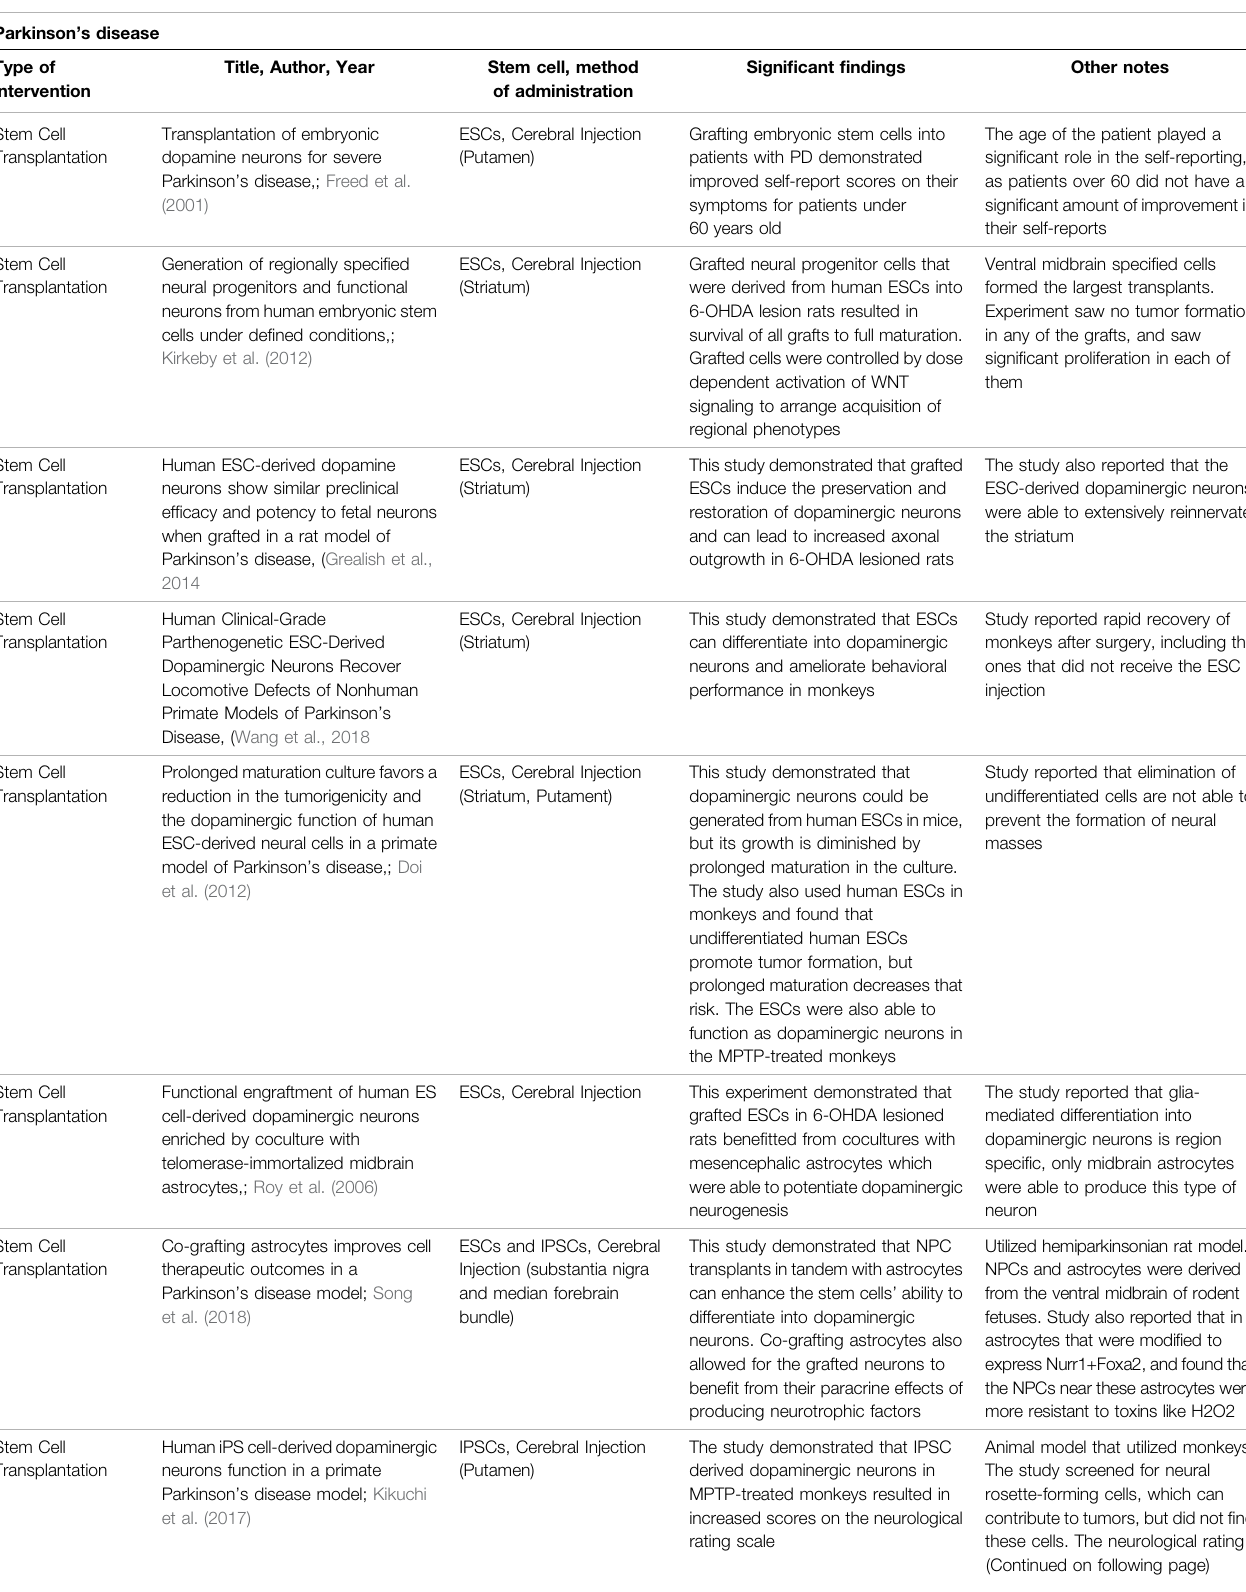
TABLE 4 | Experimental studies for Parkinson ’ s disease with stem cell transplantation, an enriched environment, exercise, and a combination of enriched environment or exercise with stem cells. Parkinson ’ s disease Type of